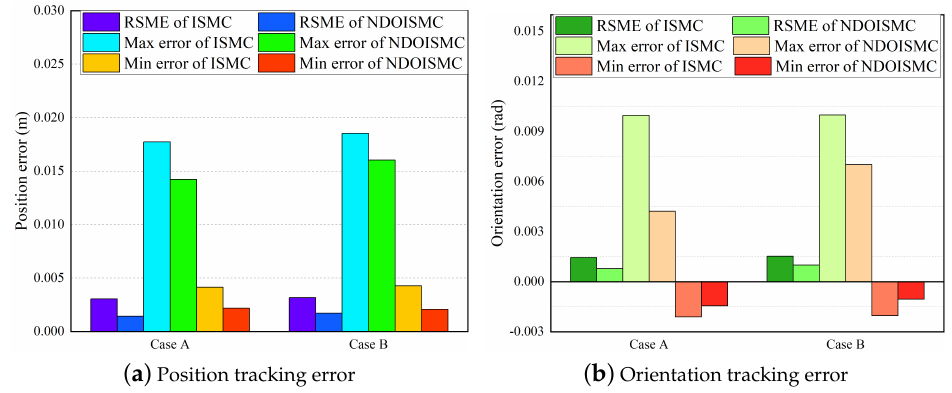
Figure 9. Comparison result in terms of RSME, max and min